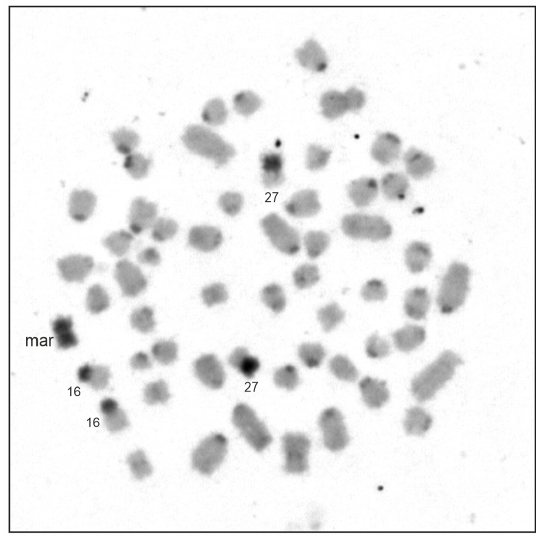
Figure 2. G ‐ banded karyotype of Elephas maximus (2n = 57,XX,+mar). The chromosomes were ar ‐ ranged according to Yang et al. [19]. The arrowheads show the NOR positions.